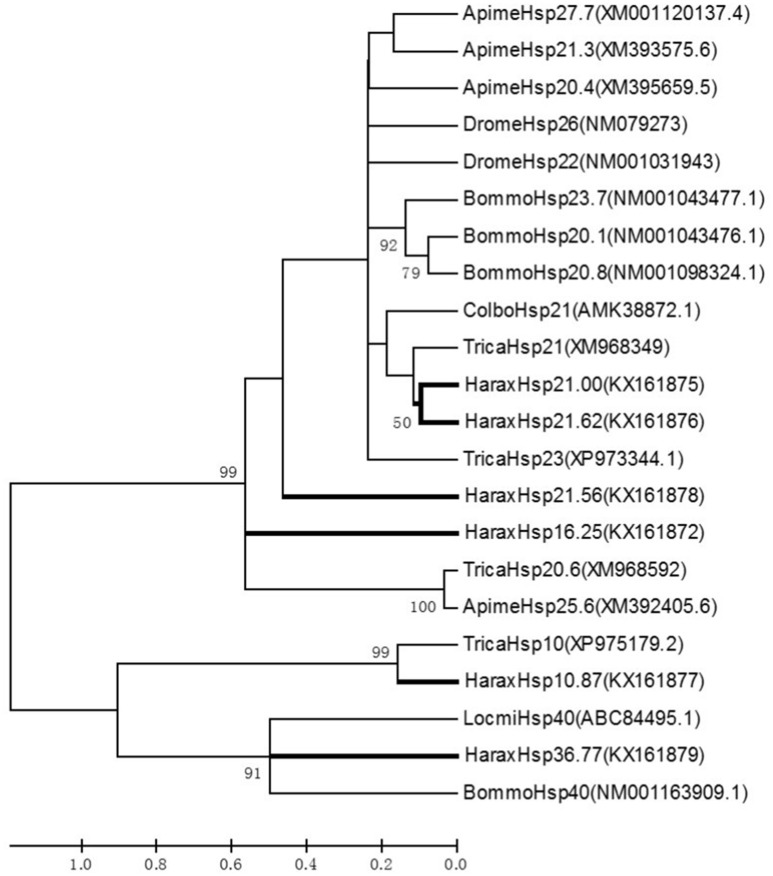
Phylogenetic analysis of sHSPs in insects. Phylogenetic tree constructed by the neighbor-joining method. Bootstrap values for 1000 replications are indicated at each node. Scale bar = 0.2 PAM. Harax, Harmonia axyridis; Apime, Apis mellifera; Bommo, Bombyx mori; Colbo, Colaphellus bowringi; Drome, Drosophila melanogaster; Locmi, Locusta migratoria; Trica, Tribolium castaneum.